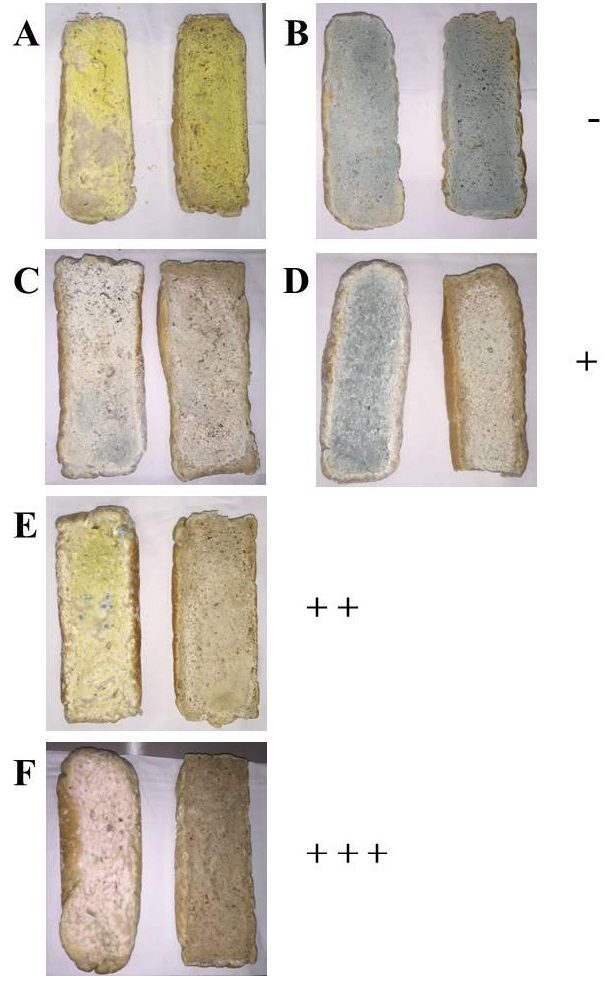
Figure 3. Bread obtained by fermentation with S. cerevisiae “Lievital” (left pictures) or co-fermented with L. plantarum UFG 121 (right pictures) after one week of storage at room temperature and artificially contaminated with A. niger CECT 2805 ( A ); P. roqueforti CECT 20508 ( B ); P. chrysogenum CECT 2669 ( C ); P. expansum CECT 2278 ( D ); A. flavus CECT 20802 ( E ); F. culmorum CECT 2148 ( F ). Antifungal activity was expressed as no/low (−), moderate (+), high (+ +), and very high (+ + +), when the contaminated area was reduced in the ranges 0–25%, 25–50%, 50–75%, and 75–100%, respectively.